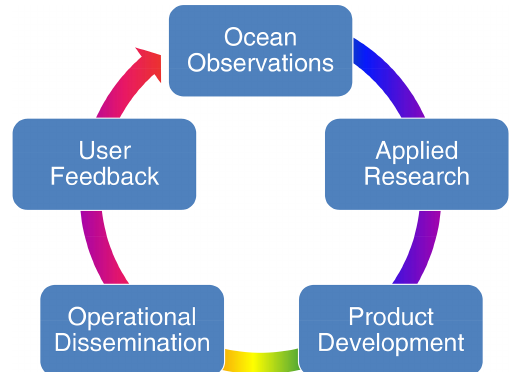
Figure 1. Evolution and life cycle of an operational ocean service. After identification of user requirement and consultation with them, ocean observations are planned or retrieved (if already existing). The observations are then used for the research focused on the de- velopment of products customized for stakeholder requirement. The products are then disseminated as routine operations, and feedbacks from the users are collected for further improvement of the prod- ucts. Due to the continuous advancements of the technology and changes in the user requirements, this cycle repeats to find the best achievable solutions for the contemporary needs at the user